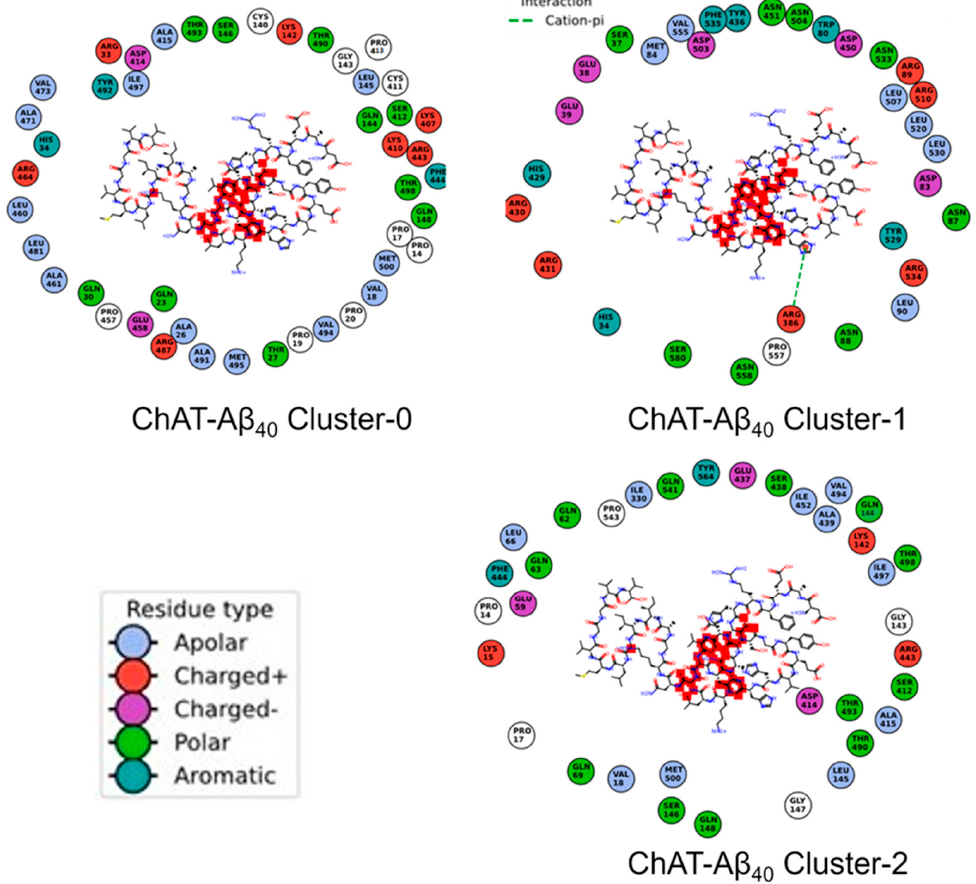
Figure 10. Contact maps between the ChAT protein and A β 40 peptides in the complexes. The amino acid residue types are given with the color codes as blue (Apolar), red (‘+’ charged), purple (‘-’ charged), light green (Polar), dark green (Aromatic).